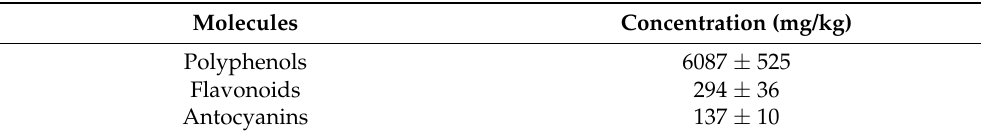
Table 4. Total phenolic content in the heat treated PPP5 dough.